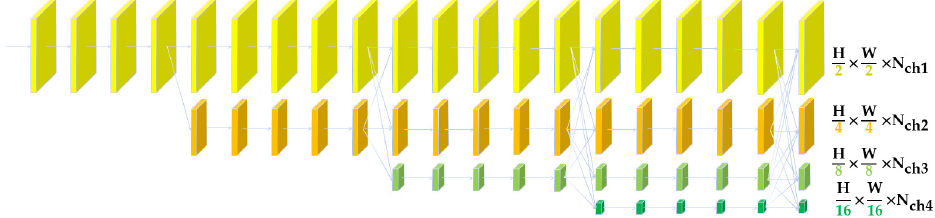
Figure 6. HRNet architecture diagram.